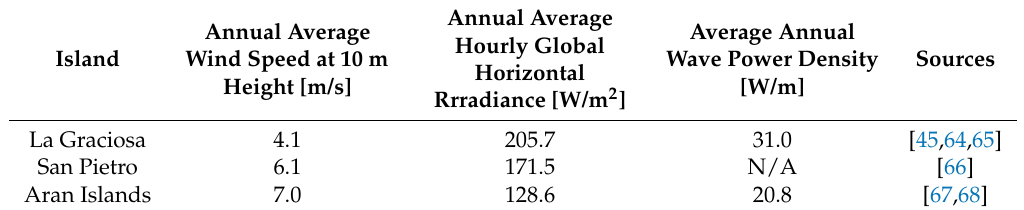
Table 3. Wind, solar and wave power potentials on the islands of La Graciosa, San Pietro and Aran.